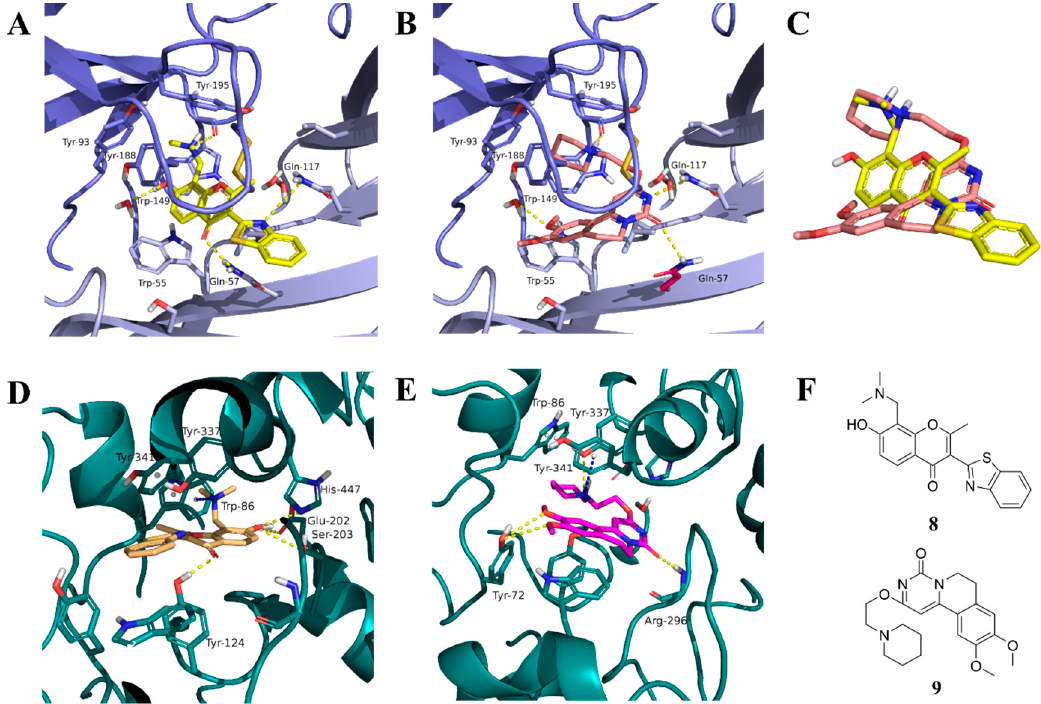
Figure 4. Binding mode of the two dual-active compounds in the α 7 nAChR homology models and AChE X-ray structure. Compound 8 in the α 7 nAChR ( A ) and AChE ( D ) binding pockets. Compound 9 in the α 7 nAChR ( B ) and AChE ( E ) binding pockets. Both compounds superimposed in the α 7 nAChR ( C ) pocket showing common pharmacophores. Compound 8 binds to the α 7 nAChR ( A ) through three hydrogen bonds (yellow dotted lines) to Q57, Q117, and W149; compound 9 exhibits similar interactions with the same amino acids Q57, Q117, and W149. In the AChE pocket, compound 8 ( D ) binds through hydrogen bonds to Y124, Q202, S203, and H447 and a cation- π interaction to W86 (blue dotted line). Compound 9 ( E ) creates hydrogen bonds to Y72, Y337, and R296 and a cation- π interaction to Y341. ( F ) Structure of compounds 8 and 9 .